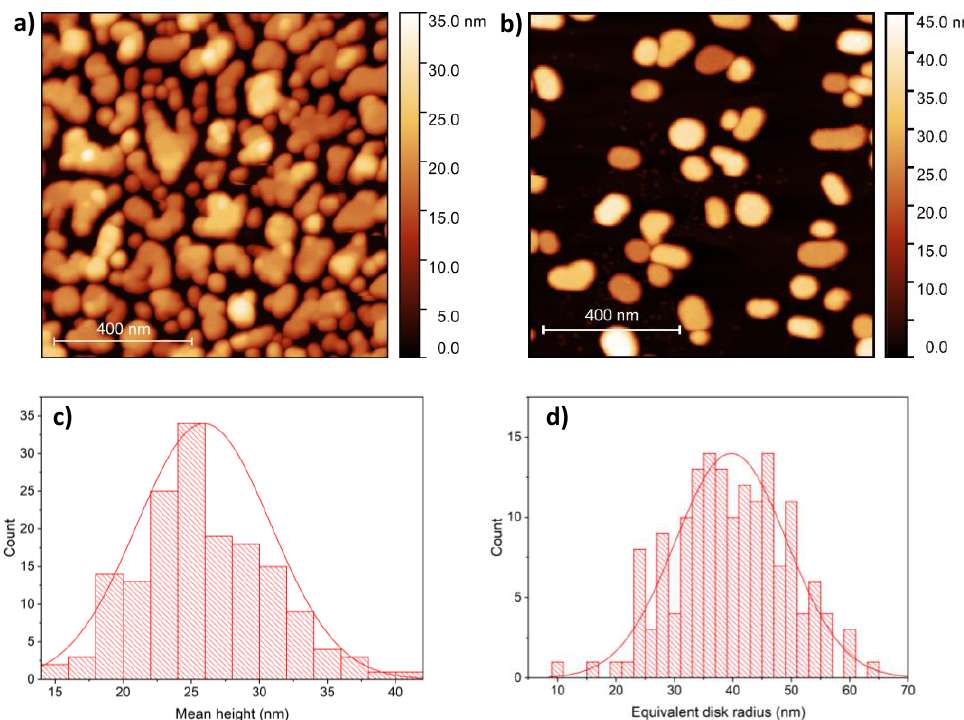
Figure 1. ( a ) Atomic force microscopy (AFM) image of 7 nm Ag as-deposited onto highly oriented pyrolytic graphite (HOPG) substrate. ( b ) AFM image of the same sample as in ( a ) after annealing at 400 °C. Mean height ( c ) and equivalent disc radius ( d ) distribution of 161 Ag NPs formed during annealing.